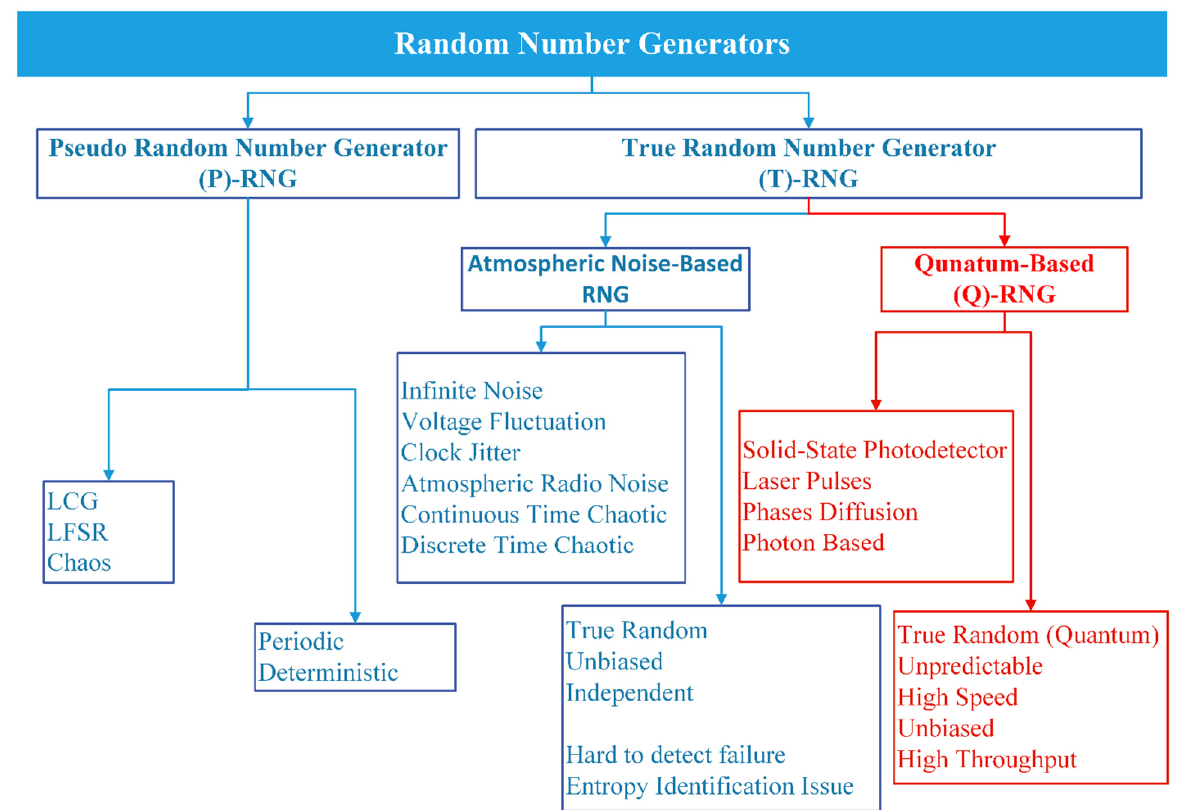
Figure 6. Categorization of Random Number Generators: generation methods, properties, disadvantages & advantages.